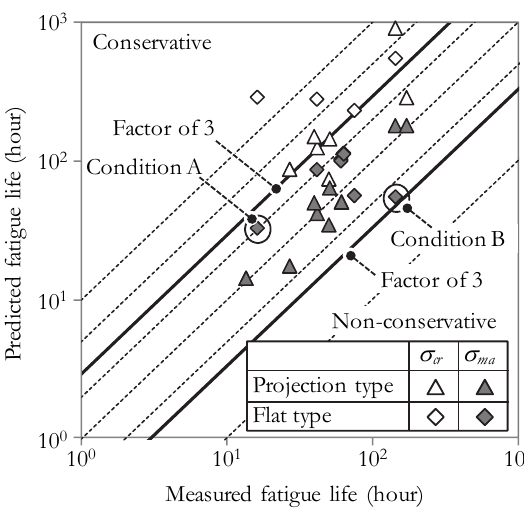
Figure 6: Comparison between predicted fatigue lives and measured fatigue